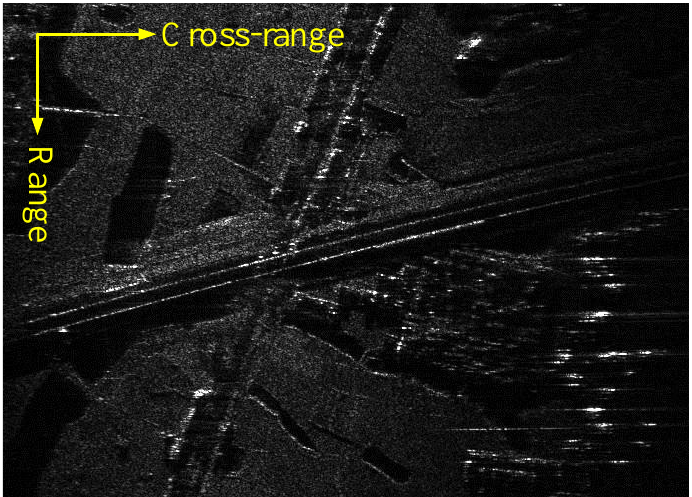
Figure 15. The stationary scene image corresponding to